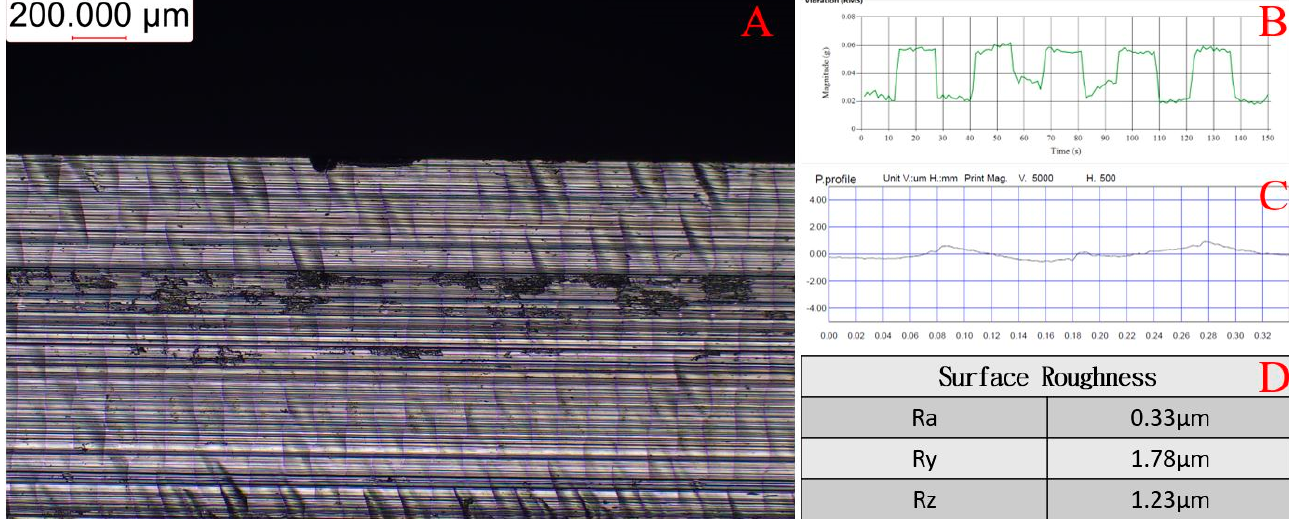
Figure 20. D5 measurement result of Parameter 2.